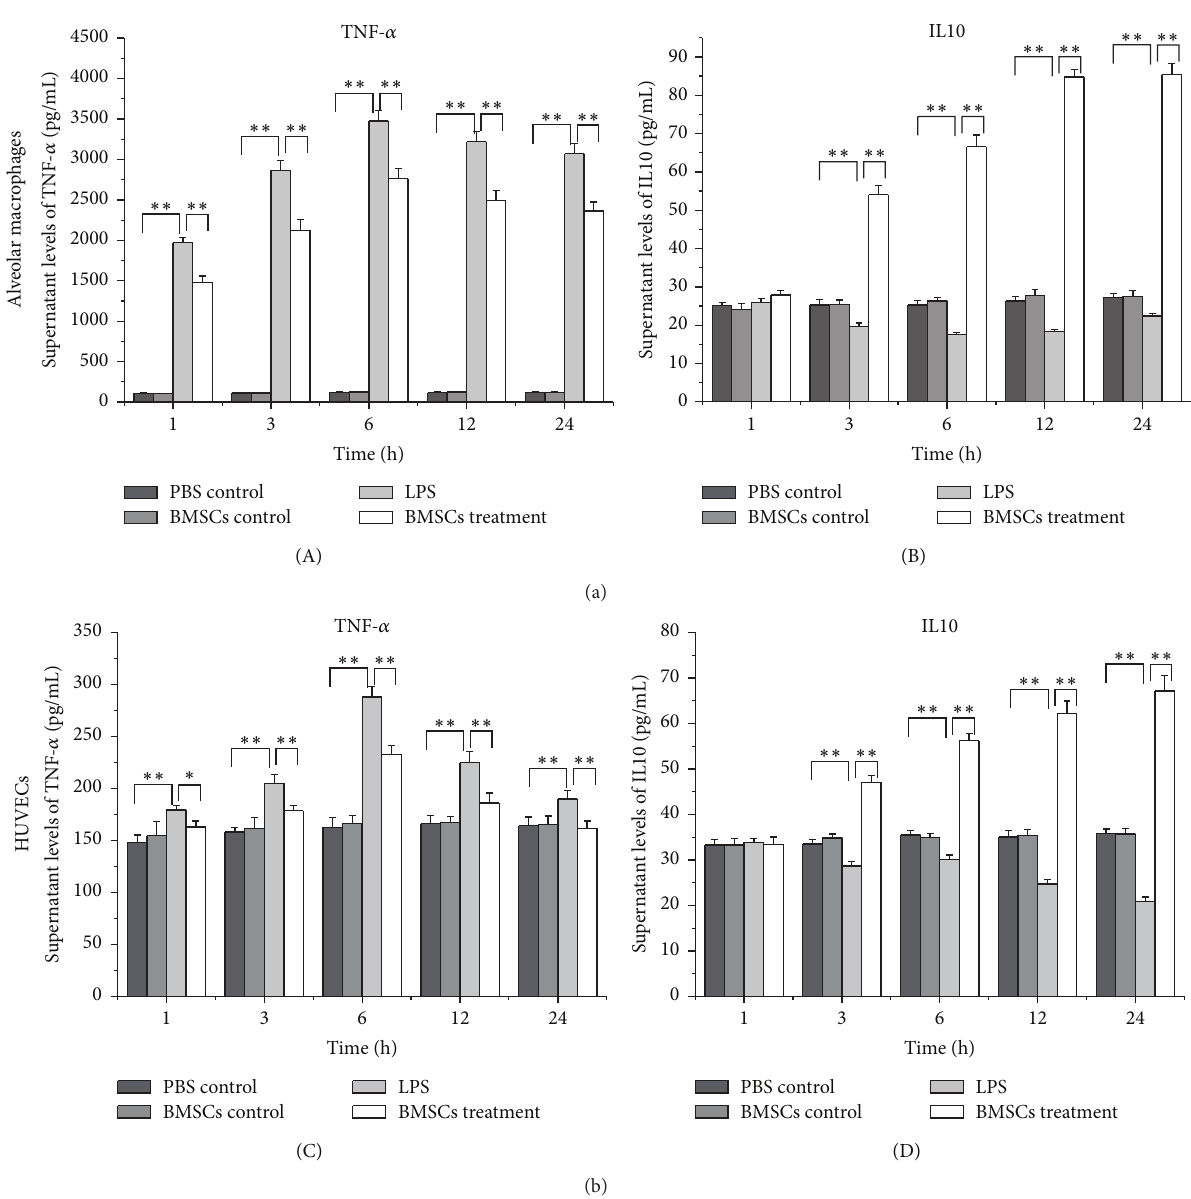
Figure 4: Coculture with BMSCs attenuates the activity of LPS to induce release of cytokines in alveolar macrophages (a) and HUVECs (b). Alveolar macrophages and HUVECs with or without coculture with BMSCs were treated with LPS or PBS for 1, 3, 6, 12, and 24 hours. The cell culture supernatant was then collected for cytokine analysis by ELISA. Data are expressed as the mean ± SD from three experiments. ∗ 𝑃 < 0.05 , ∗∗ 𝑃 < 0.01 .